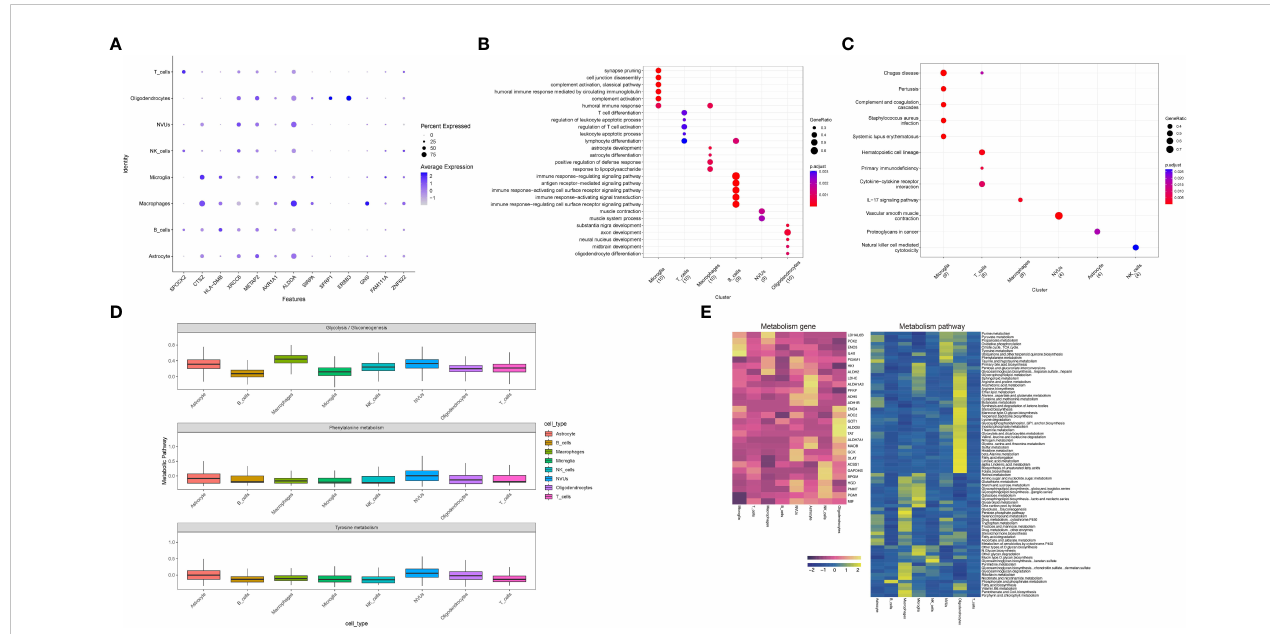
FIGURE 8 Functional enrichment analysis and metabolic analysis at the level of single-cell subpopulations. (A) Expression of co-expressed genes on functional subgroups. (B, C) Enrichment analysis of single cell subpopulations. (D) Metabolic pathway expression quanti fi cation for single-cell subpopulations. (E) Quanti fi cation of metabolic pathways and metabolism-related gene